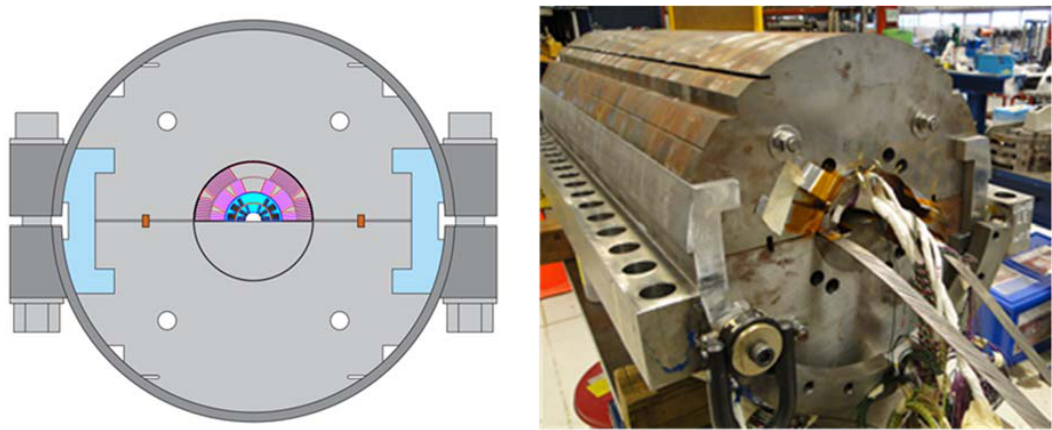
Figure 10. Bi2212 and 60 mm aperture 2-layer Nb 3 Sn half-coils inside HFDM dipole mirror structure ( left ); a picture of the HFDM mirror structure with 60 mm Nb 3 Sn coil inside ( right ).